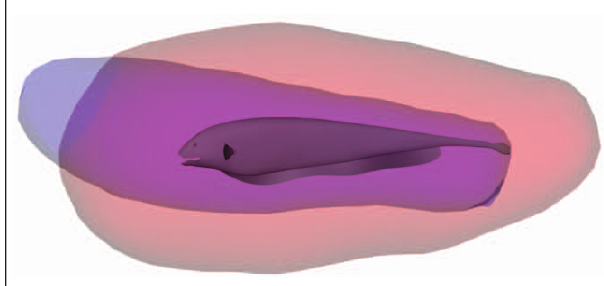
Figure 7. The Measured Stopping Motor Volume for A. albifrons (Blue) and the Computed D. magna Sensory Volume (Red) Interactive 3-D version is available as Figure S6.